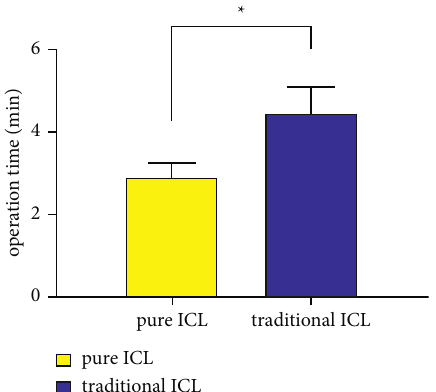
Figure 6: Comparison of operation time between the two groups. ∗ The difference is statistically